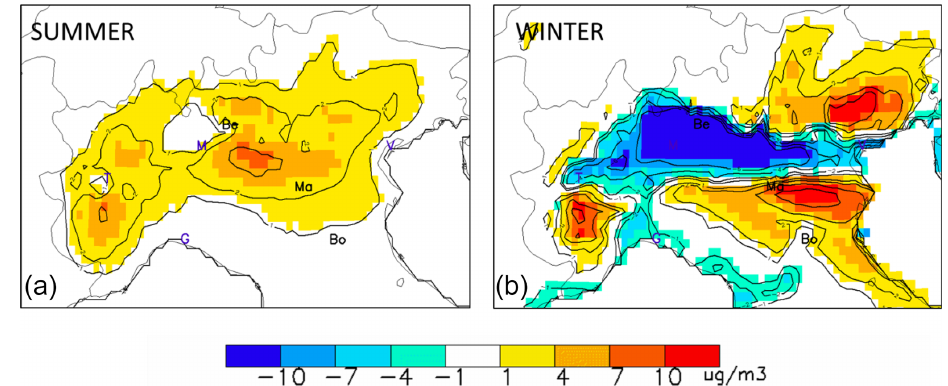
Figure 3. Winter (b) and summer (a) chemical regimes obtained from an emission reduction level of α = 25%. The maps represent the − P 25% P 25% (unit: µgm − 3 ) indicator that shows the NO x - and NH 3 -sensitive areas in yellow/red and blue, respectively. The abbreviations NH 3 NO x Be, Ma and Bo indicate the location of Bergamo, Mantua and Bologna, respectively. Other cities are indicated by their first letter for convenience: Venice, Milan, Turin and Genoa.